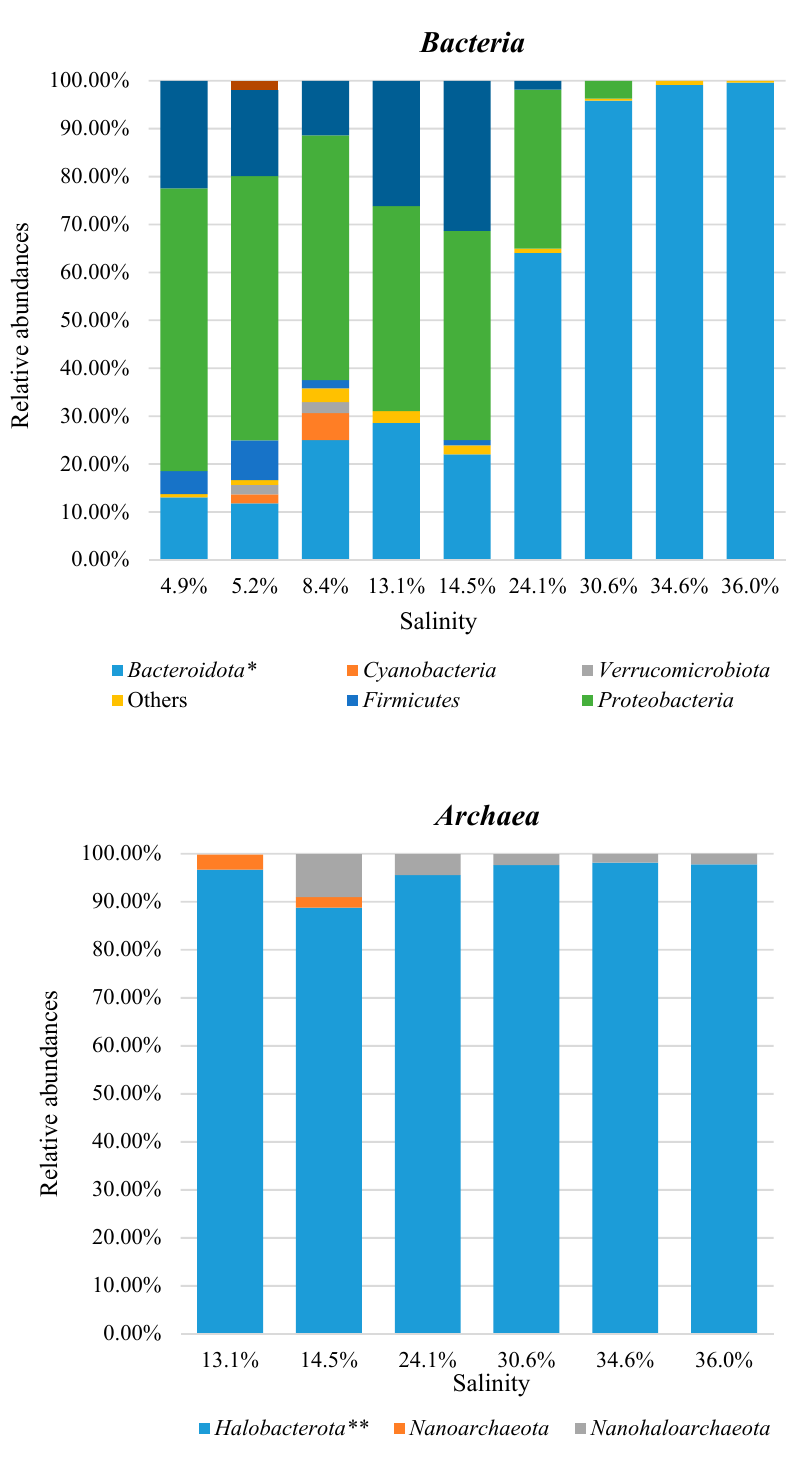
Figure 4. Bar charts of Bacteria and Archaea phyla identified at different salinities in MdS (Margherita di Savoia) saltern. Groups with relative abundances < 1.0% were joined as ‘Others’. Salinity is reported as salt percentage (w/v). * also known as Bacteroidetes ; ** also known as Euryarchaeota .